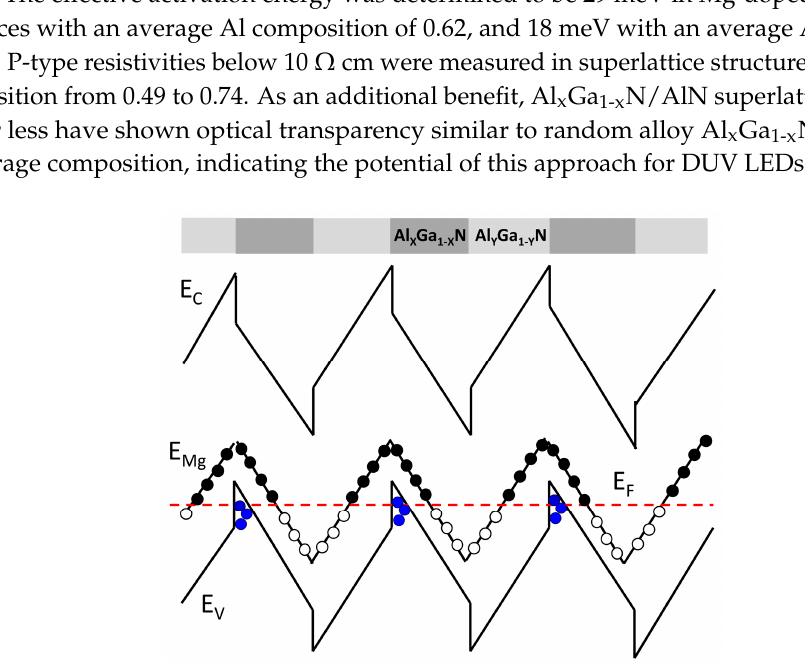
Figure 10. Schematic of the band structure of an Mg-doped Al x Ga 1-x N/Al y Ga 1-y N (x < y) superlattice. The dashed red line represents the Fermi energy; the empty circles represent the energy of the Mg acceptor when ionized, and the blue solid circles represent the accumulation of holes at the heterointerfaces.